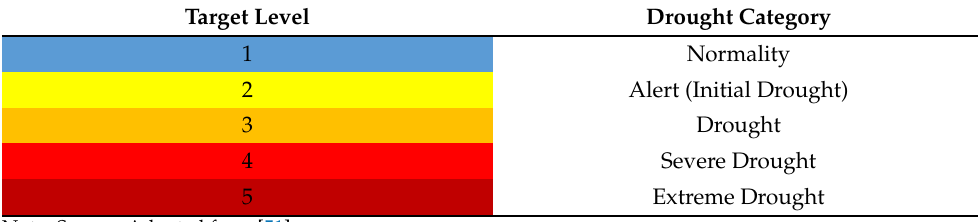
Table 7. Classification of the Target Levels according to drought